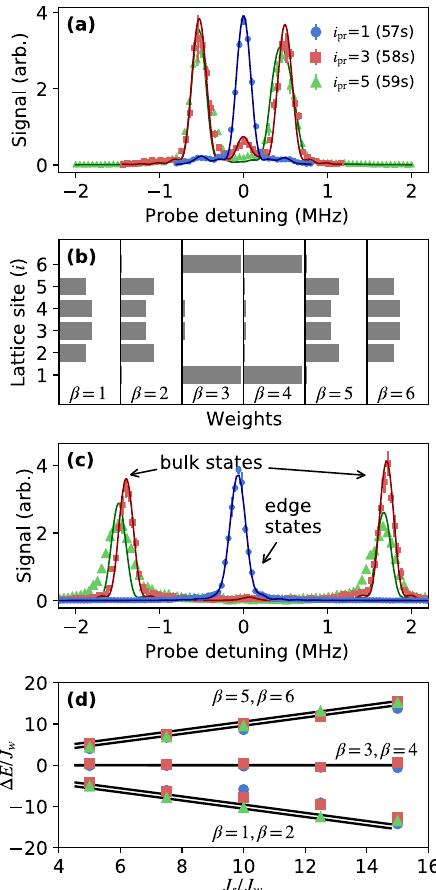
Fig. 2 Band structure and state decomposition for the con fi guration with TPS [Fig. 1b]. ( a ) Rydberg excitation spectra when coupling to i pr = 1(57 s ), i = 3(58s), and i = 5(59s) for J s / J w = 5. Probe detuning ( Δ i pr ) is from the pr pr undressed Rydberg level. i pr = 3, 5 spectra have been multiplied by a factor (cid:4) (cid:3) j 2 , obtained from of 2 for clarity. ( b ) State decomposition weights, j β j i direct diagonalization of Eq. (1) for J s / J w = 5. Edge states correspond to β = 3, 4. ( c ) Same as ( a ) except for J s / J w = 15. ( d ) Peak positions ( ε β ) in spectra such as in ( a , c ), giving the bulk and edge state energies versus J s . Measurements match the band structure calculated by direct diagonalization of Eq. (1). Bulk states split by ~ J w are unresolved in the spectra. All energies are scaled by J w . Lines in ( a ) and ( c ) are fi ts of each feature with a sinc-squared lineshape corresponding to the 5 μ s laser exposure time convolved with a 100 kHz full-width-half-maximum (FWHM) additional broadening. All error bars denote one standard error (s.e.) of the